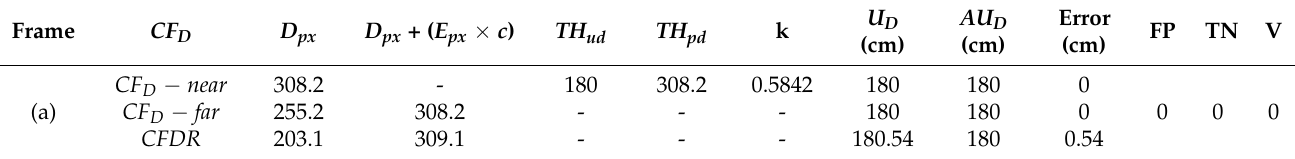
Figure 7. The graphic depiction of CSP-ized YOLOv4 convergence over GIoU, objectness, classifica- tion, precision, recall, and mAP score. Table 3. Quantitative evaluation of the DepTSol model, where TH ud represents the threshold distance in cm, TH pd is the threshold distance in pixels, U D shows the predicted unit distance at each CF D level, AU D is the actual unit distance, AE is the absolute error, and V represents the number of violations per